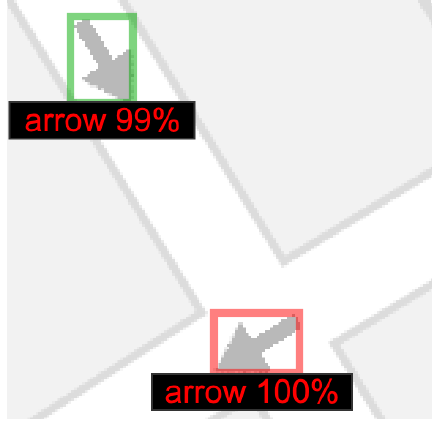
Figure 7. Arrow position detection for Google